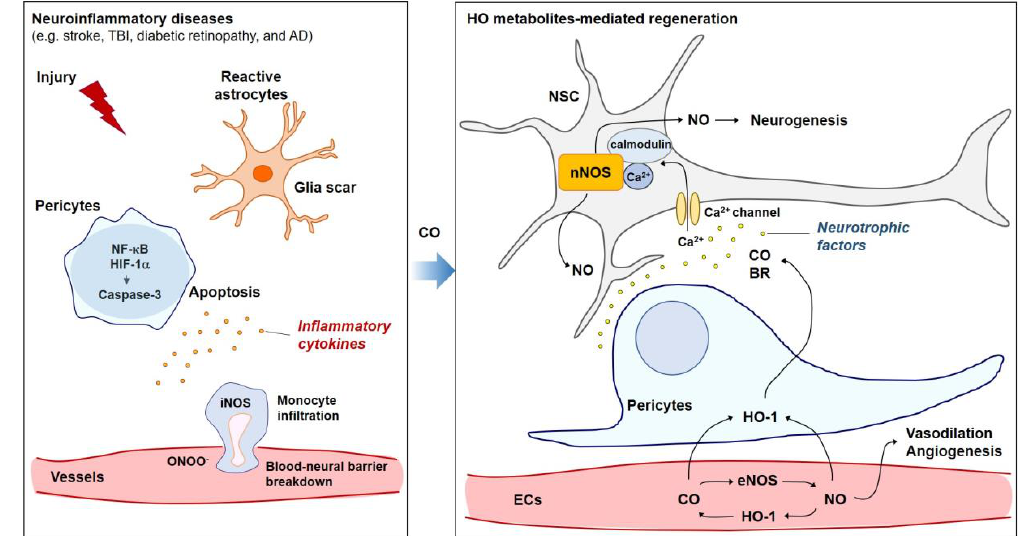
Figure 1. Inflammatory response is mediated by the nuclear factor κ -light-chain-enhancer of activated B cells (NF- κB), hypoxia -inducible factor (HIF)-1 α , and reactive nitrogen species (RNS (e.g., ONOO − )) production. This is strongly associated with glia scar formation, pericyte cell death, and invasion of monocytes in the acute phase of various vascular injuries such as stroke, traumatic brain injury (TBI), diabetic retinopathy, and Alzheimer’s disease (AD). Heme oxygenase (HO) metabolites, such as carbon monoxide (CO) and bilirubin (BR) play a role in anti-inflammation and cytoprotection through inhibiting the NF- κB -mediated production of various cytokines. After CO treatment, CO-mediated HO-1 induction in endothelial cells (ECs) may facilitate angiogenesis partly via crosstalk between HO/CO and endothelial nitric oxide synthase (eNOS)/nitric oxide (NO). In addition, the HO metabolites CO and BR may stimulate neurogenesis partly via a Ca 2+ /calmodulin-mediated neuronal NOS (nNOS)/NO pathway in neural stem cells (NSCs).